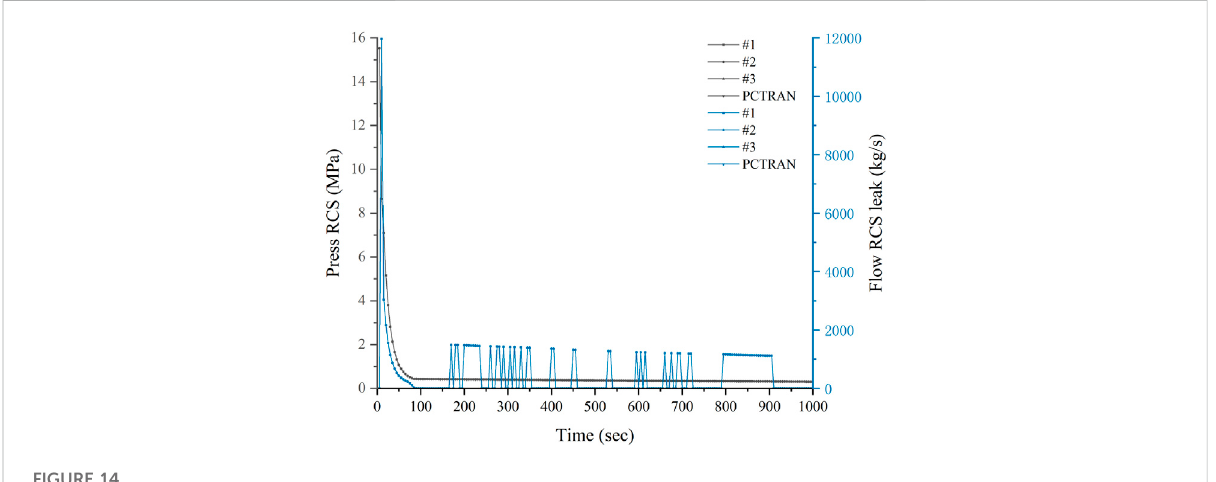
Result of LBLOCA-Cold